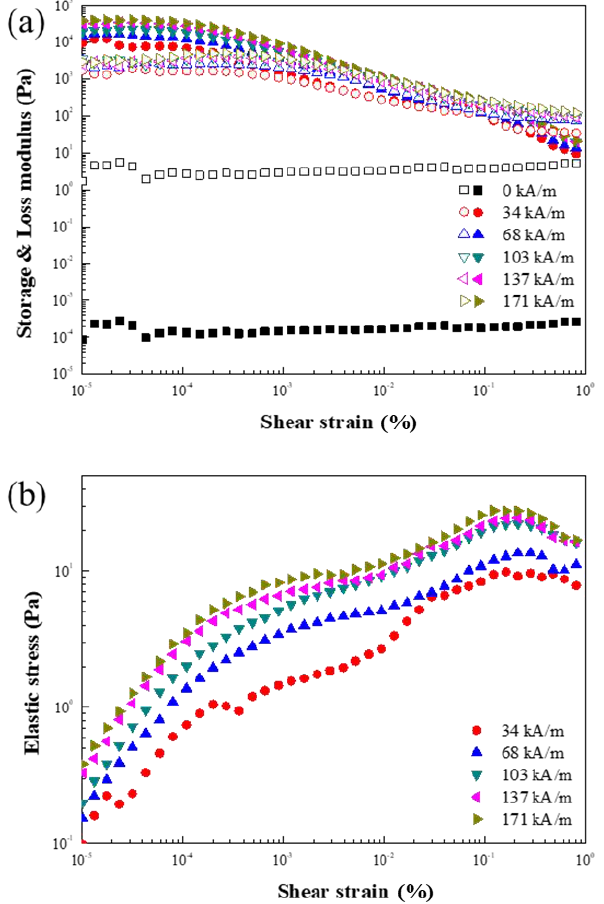
Figure 16. ( a ) Strain amplitude sweep measurement (closed: G′, open: G″) as a function of the strain of ZnFe 2 O 4 /PMA-based MR fluid and ( b ) τ (cid:48) as a function of γ obtained using the G (cid:48) of ZnFe 2 O 4 /PMA-based MR fluid and ( b ) τ’ as a function of 𝛾 obtained using the G’ .